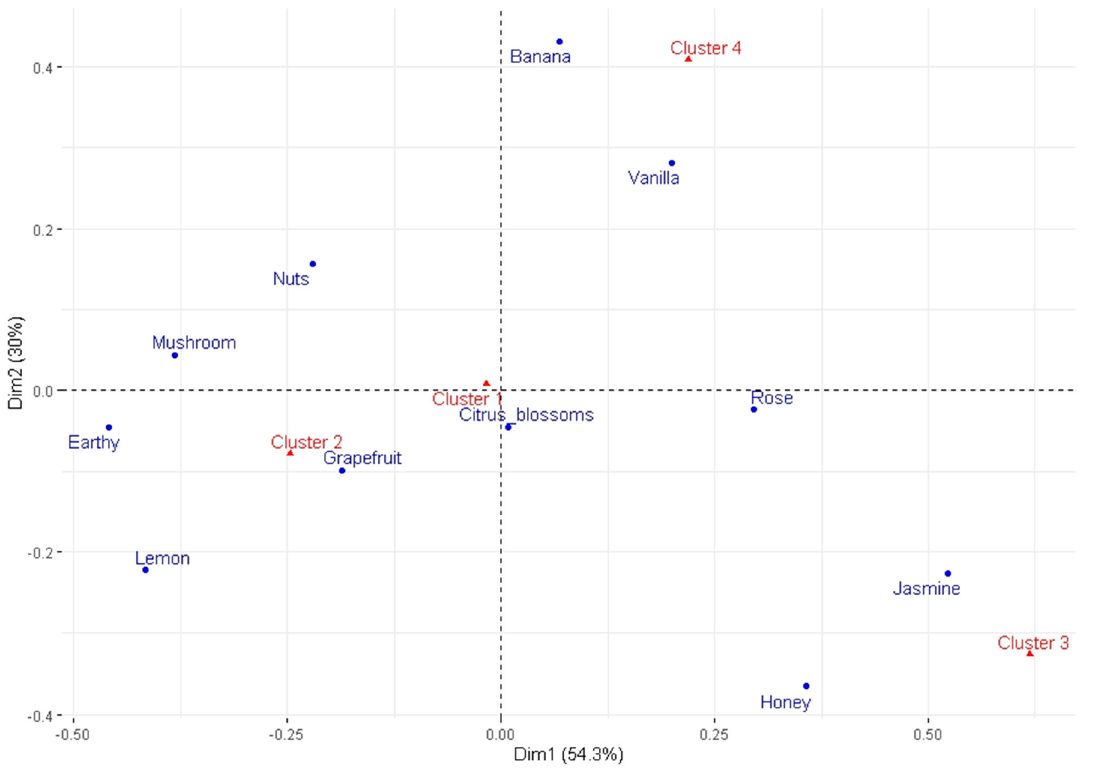
Figure 3. The two dimensions (symmetrical plot) of the correspondence analysis in the cluster and descriptor space.